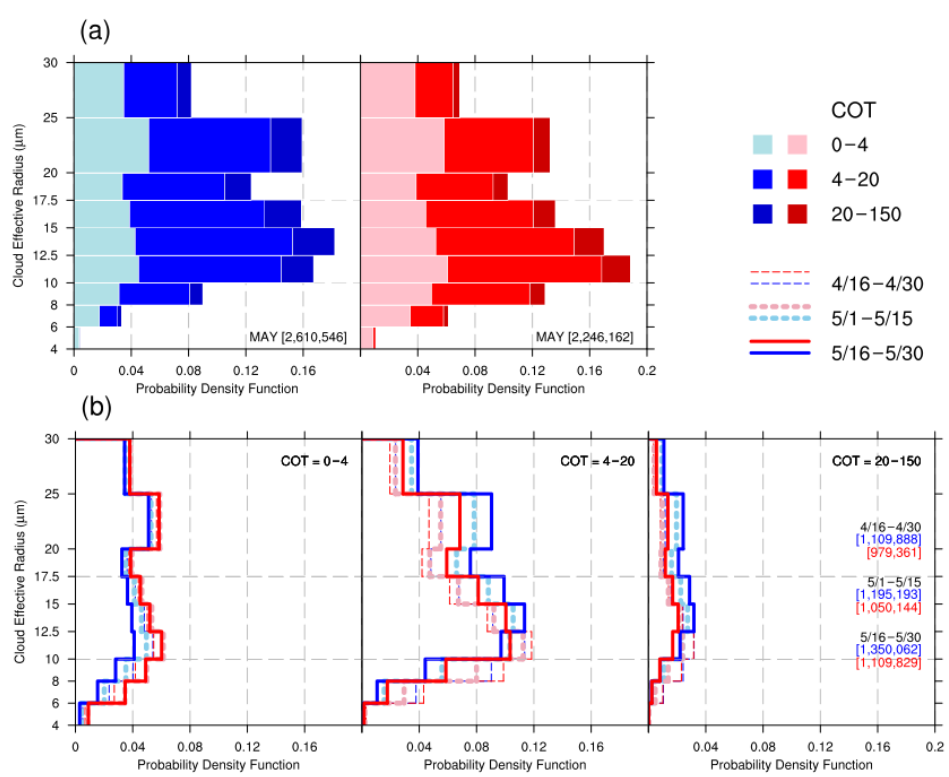
Figure 7. The monthly (May) and seasonal variation of the marginal probabilities of CER with respect to the three categories of COT compiled over the ICP as collected from cold (blue tone) and warm (red tone) years. The seasonal variation is revealed by the statistics of three 15-day periods from 16 April to 30 May of the cold and warm years. The numbers in square brackets are the total counts for these statistical periods. The COT and CER are for liquid water clouds in the daytime; COT is a dimensionless quantity, and CER is in μ m. The marginal probabilities of CER are derived from the joint histograms of COT binned against CER. The COT is grouped into three categories of newly aggregated bins from the original COT histogram bins: 0 – 4, 4 – 20, and 20 – 150. Three sets of the marginal probabilities of CER are obtained by integrating the joint probability (relative frequency) over the specific ranges of the aggregated bins from the three corresponding COT categories, respectively. ( a ) The marginal probabilities of May displayed as stacked histograms. ( b ) The marginal probabilities of 15-day periods displayed as overlapping histograms, with each plot panel for each individual category. The x -axis is probability, the y -axis is CER.